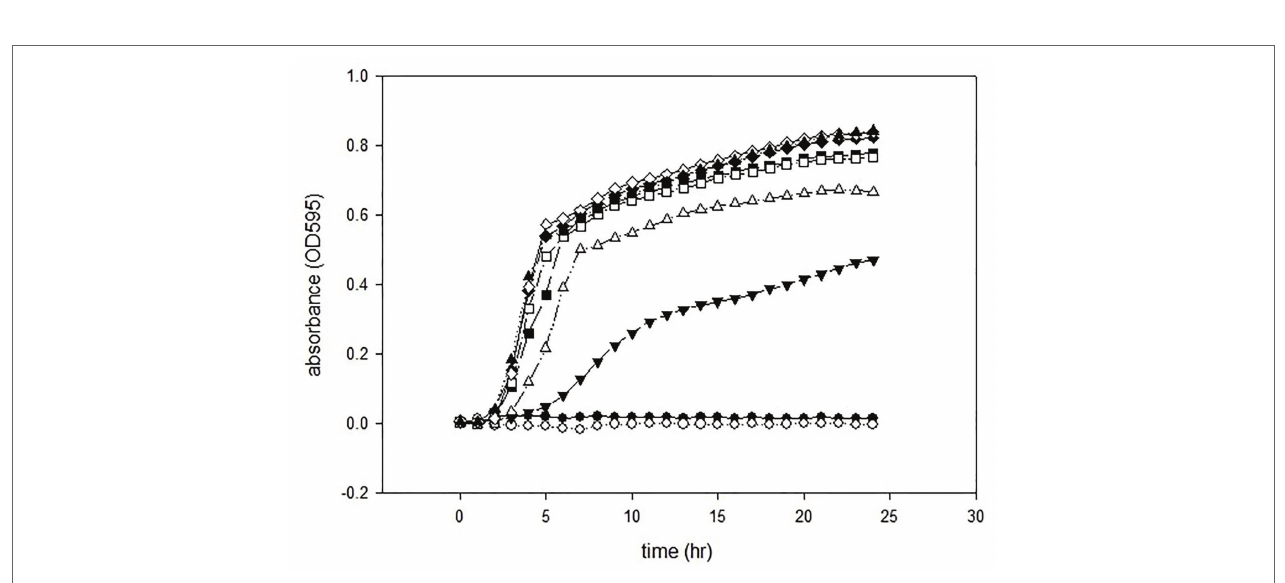
FIGURE 2 | Minimum inhibitory concentrations of GCEO against Escherichia coli O157:H7. GCEO used at 2% ( ● ), 1% ( ○ ), 0.5% ( ▼ ), 0.25% ( ∆ ), 0.0125% ( ■ ), 0.063% ( □ ), 0.031% ( ♦ ), 0.015% (◊), and positive control ( ▲